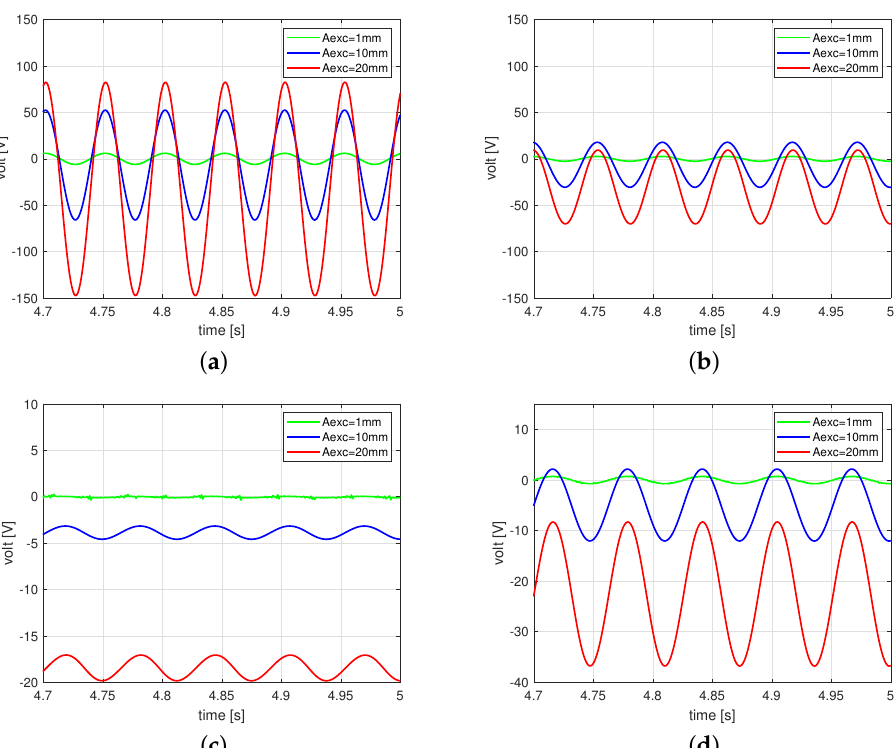
Figure 8. Voltage time series at three selected excitation amplitudes for ( a ) + 30 ◦ / − 30 ◦ set, ( b ) + 30 ◦ / + 30 ◦ , ( c ) + 60 ◦ / − 60 ◦ , and ( d ) + 60 ◦ / + 60 ◦ , respectively.